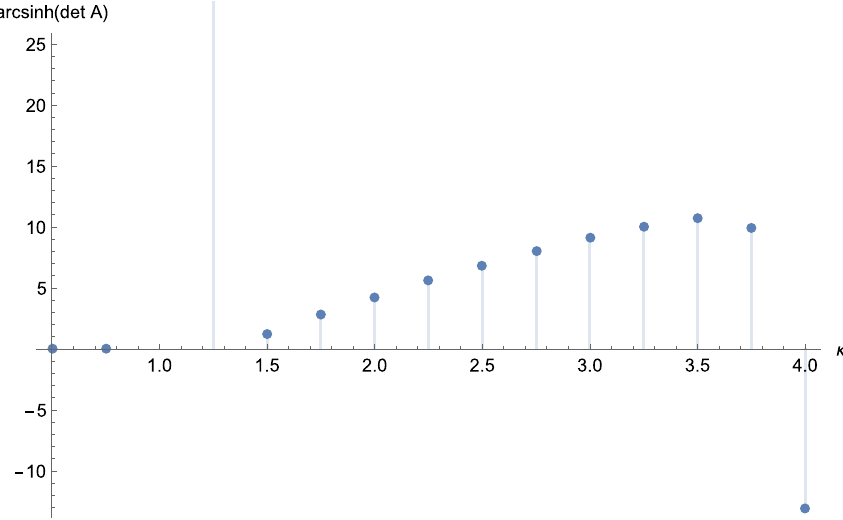
Fig. 2 Behaviour of arcsinh ( det A (κ)) as a function of κ for the unique four-dimensional elliptic critical solution. For clarity, we plot arcsinh ( det A (κ)) in order to limit the range of values